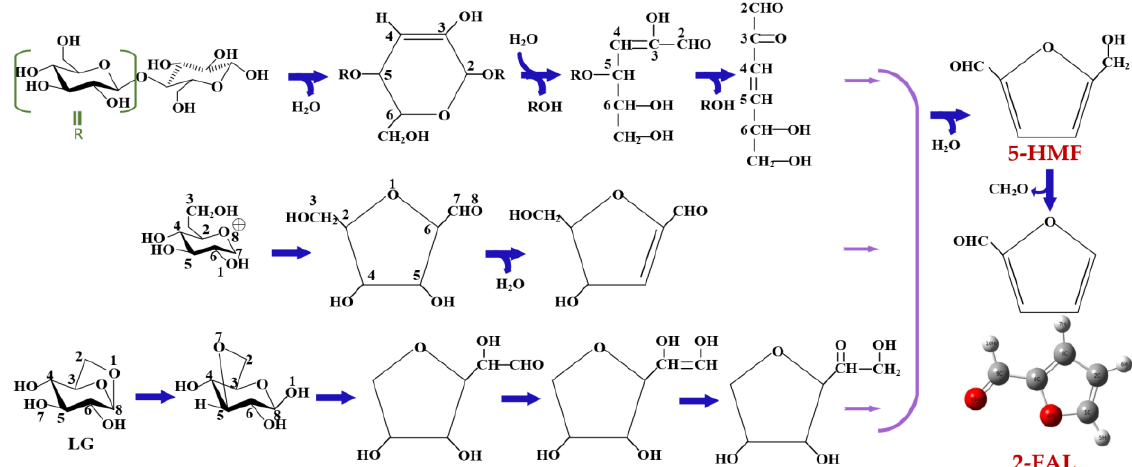
Figure 5. Three pathways of 5-hydroxymethyl furfural and furfural.